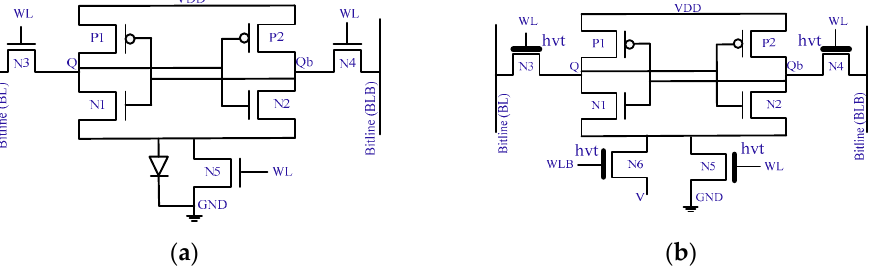
Figure 10. Leakage control mechanisms for SRAM cells using internal components and external control signals for raised ground levels [45,46]. ( a ) SRAM cell with virtual ground; ( b ) asymmetric SRAM cell with virtual ground.